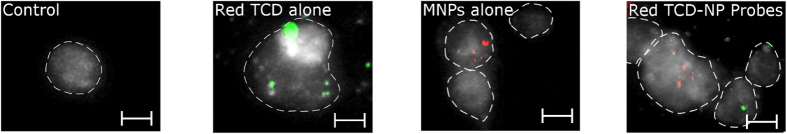
Combined optical and PA images at two wavelength (532 nm and 820 nm) of breast cancer cells (MDA-MB-231) with TCD alone and TCD-NP probes.Four samples: control with no TCD or MNPs; samples incubated overnight with TCD, MNPs or TCD-NP probes. 532 nm PA imaging represented by green overlay and 820 nm PA imaging represented by red overlay. A dotted line has been drawn to highlight the approximate perimeter of the cell. Bar scale, 10 μm.